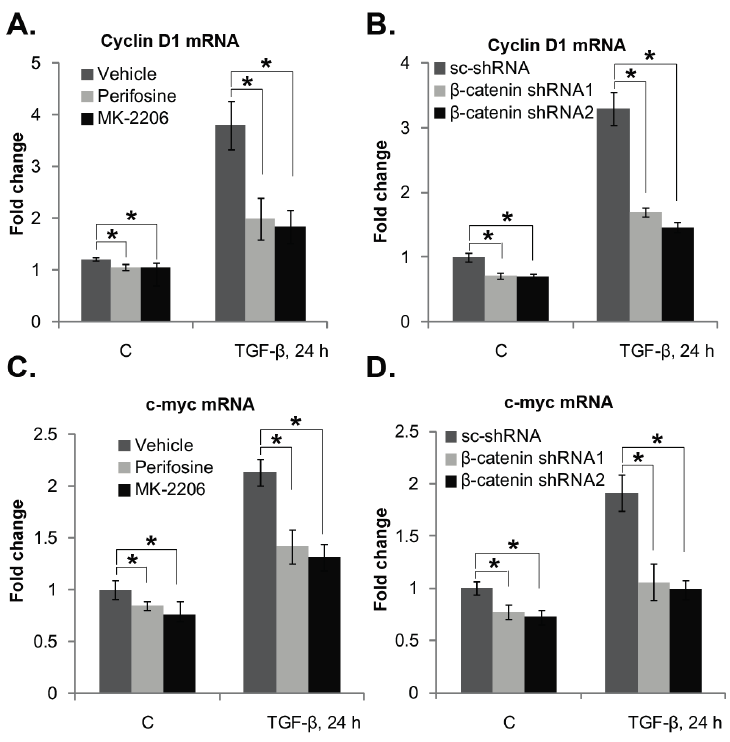
Figure 5. Akt activation and β -catenin are important for TGF- β 1-induced cyclin D1/c-myc transcription in mouse PSCs. Mouse PSCs were pre-treated with perifosine (2.5 μ M) or MK-2206 (5 μ M) for one hour, followed by TGF- β 1 (25 ng/mL) stimulation. Cells were further cultured, after 24 h, and the mRNA expression of cyclin D1 ( A ) and c-myc ( C ) was tested by real-time PCR. The lentiviral particles containing β -catenin-shRNA-1, β -catenin-shRNA-2 or scramble-shRNA (15 μ L/mL each) were added to mouse PSCs (Day 4) for 48 h; afterwards, cells were treated with TGF- β 1 (25 ng/mL). Cells were further cultured for 24 h, and the mRNA expression of cyclin D1 ( B ) and c-myc ( D ) was tested by real-time PCR. Experiments in this figure were repeated three times, and similar results were